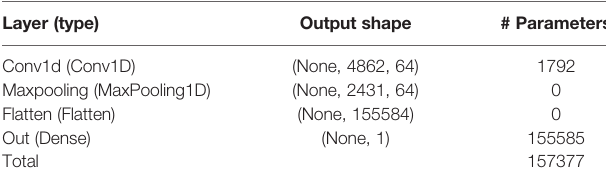
TABLE 1 | Layer name and type, output data shape of the layer, and number of trainable parameters per layer for the model with the Bayesian optimized model averaged hyperparameters using the simulated